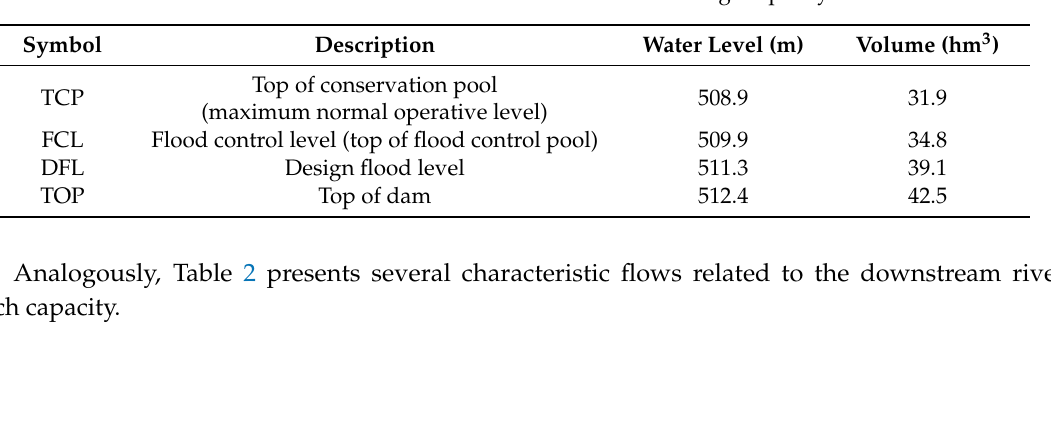
Table 2. Downstream river characteristic capacity (flows).